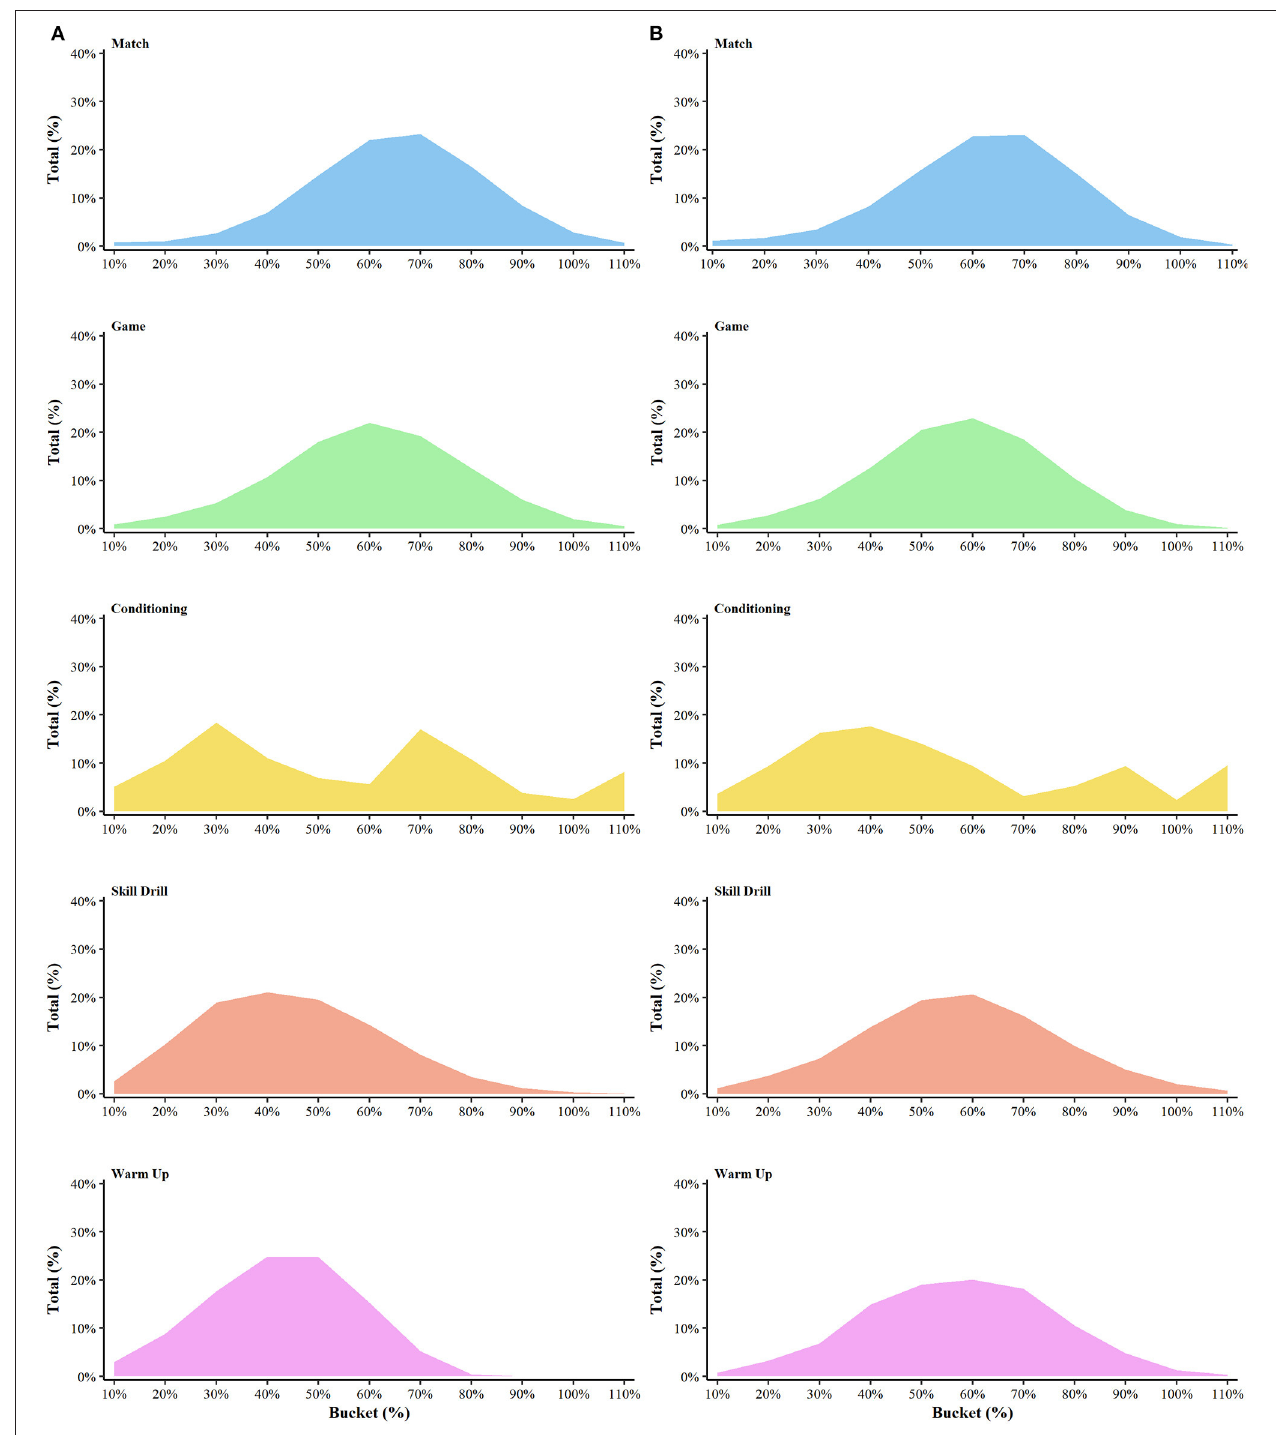
FIGURE 3 | Distribution of distance (A) and impulse (B) for each drill type.